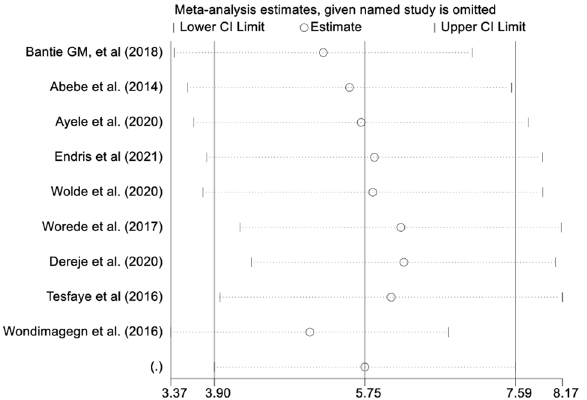
Figure 4. Sensitivity analysis of the studies included in systematic review and meta analysis on prevalence of undiagnosed diabetes mellitus in Ethiopia, 2021.